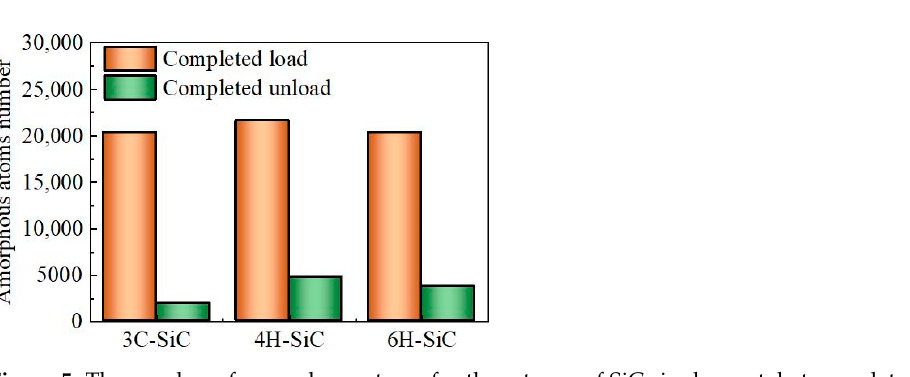
Figure 5. The number of amorphous atoms for three types of SiC single crystal at completed load and completed unload.